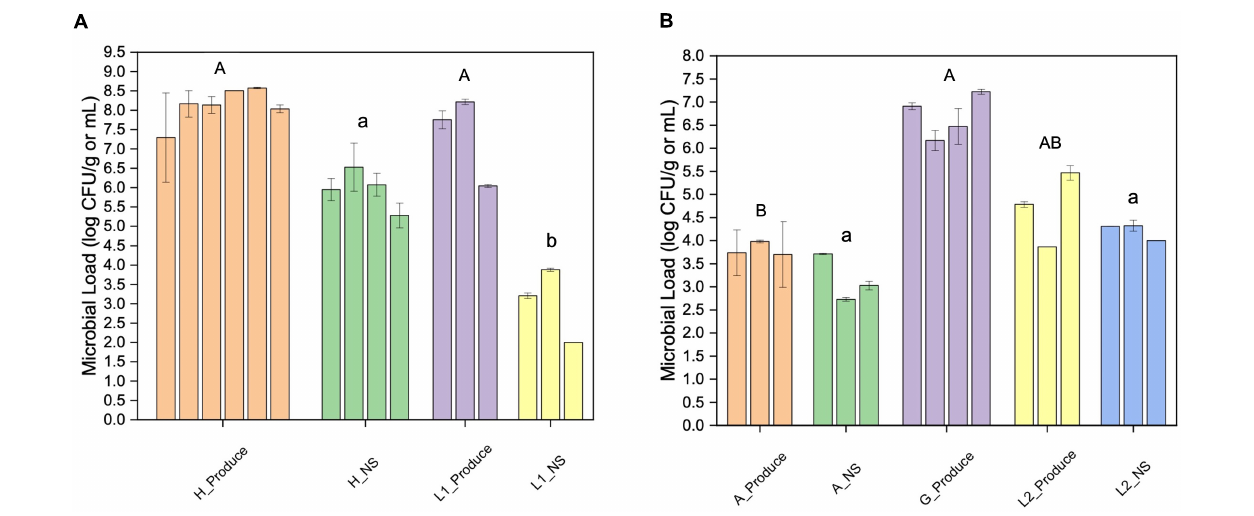
FIGURE 1 | Aerobic plate counts of fresh produce and their nutrient solutions from different sampling locations. (A) Microgreen (Produce) and the nutrient solution (NS) from farm H and laboratory system 1 (L1); (B) lettuce (Produce) and the nutrient solution (NS) from farm A, grocery store (G), and lab system 2 (L2). The error bar indicates the standard deviation (SD). Different upper or lower-case letters indicate significant differences between sample groups ( p <